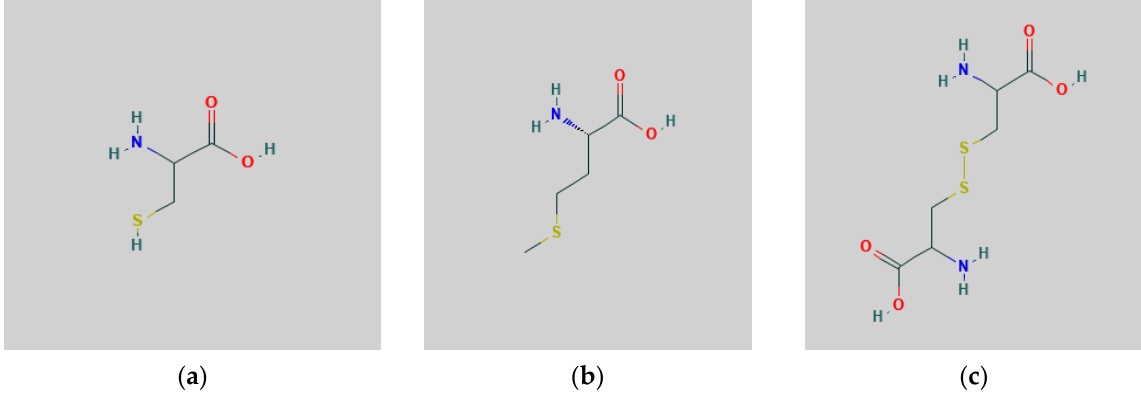
Figure 1. Structural constituents of essential sulphur containing amino acids: ( a ) Cysteine; ( b ) methionine; ( c ) cystine. Note: cystine comprises two cysteine molecules linked together by an S–S (sulphur-sulphur) bond.